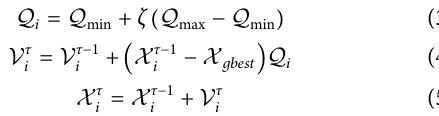
Frontiers in Robotics and AI |